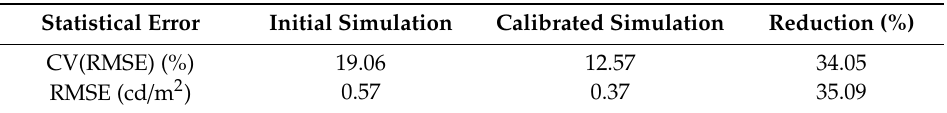
Table 8. CV(RMSE) and RMSE calculated for the initial simulation and the simulation of the calibrated model.